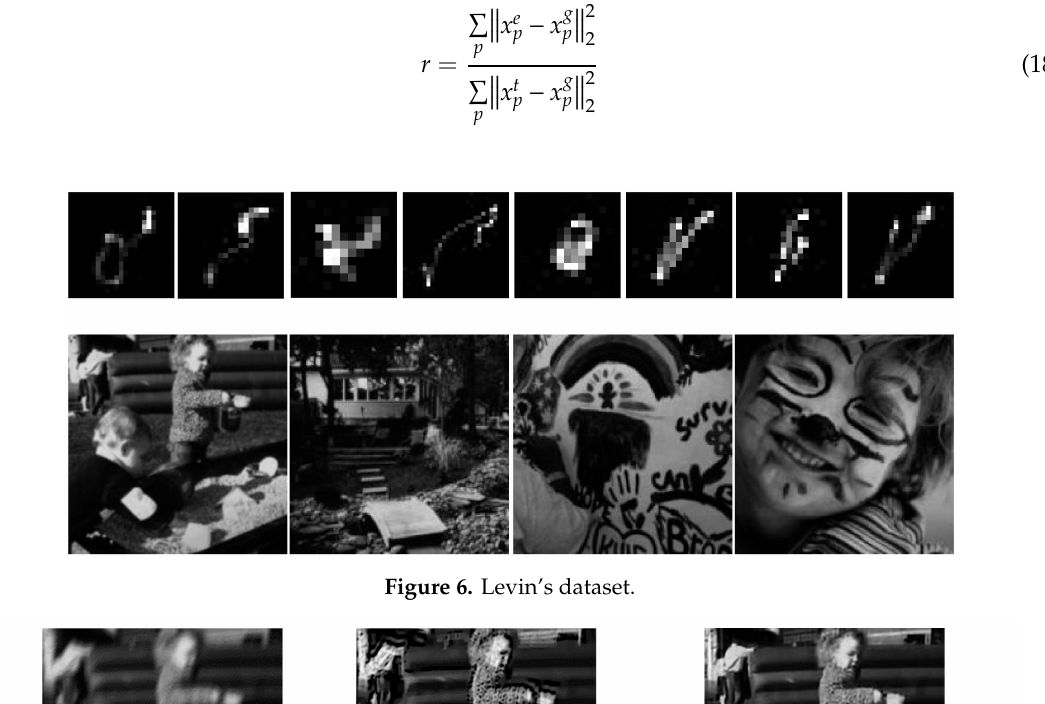
Figure 6. Levin’s dataset.